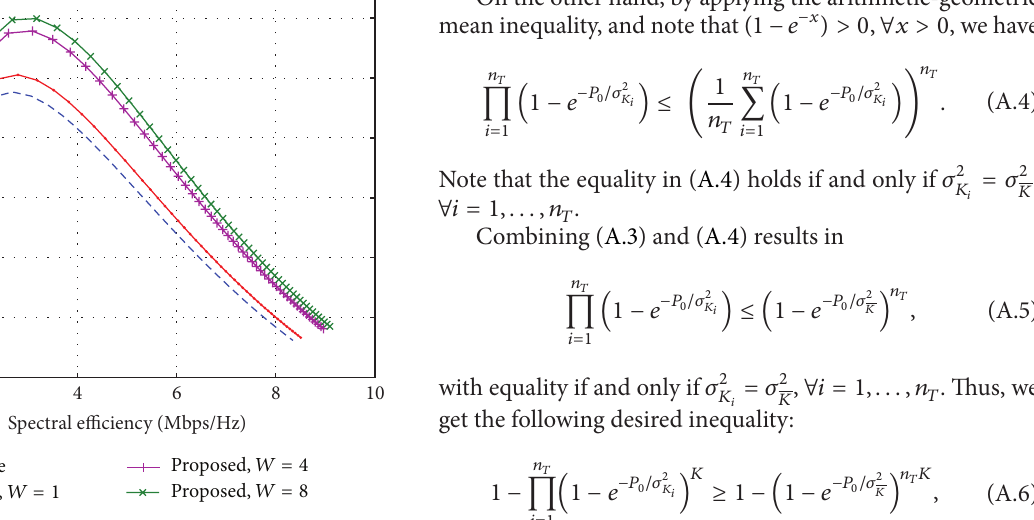
Figure 8: Energy efficiency versus spectral